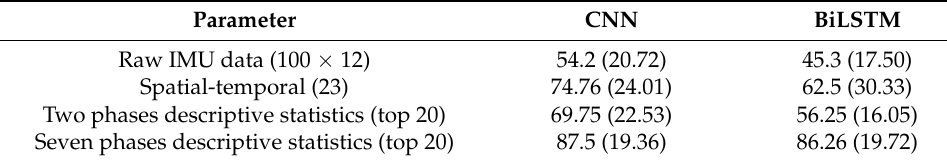
Table 6. Evaluation result of deep learning models (accuracy (standard deviation),